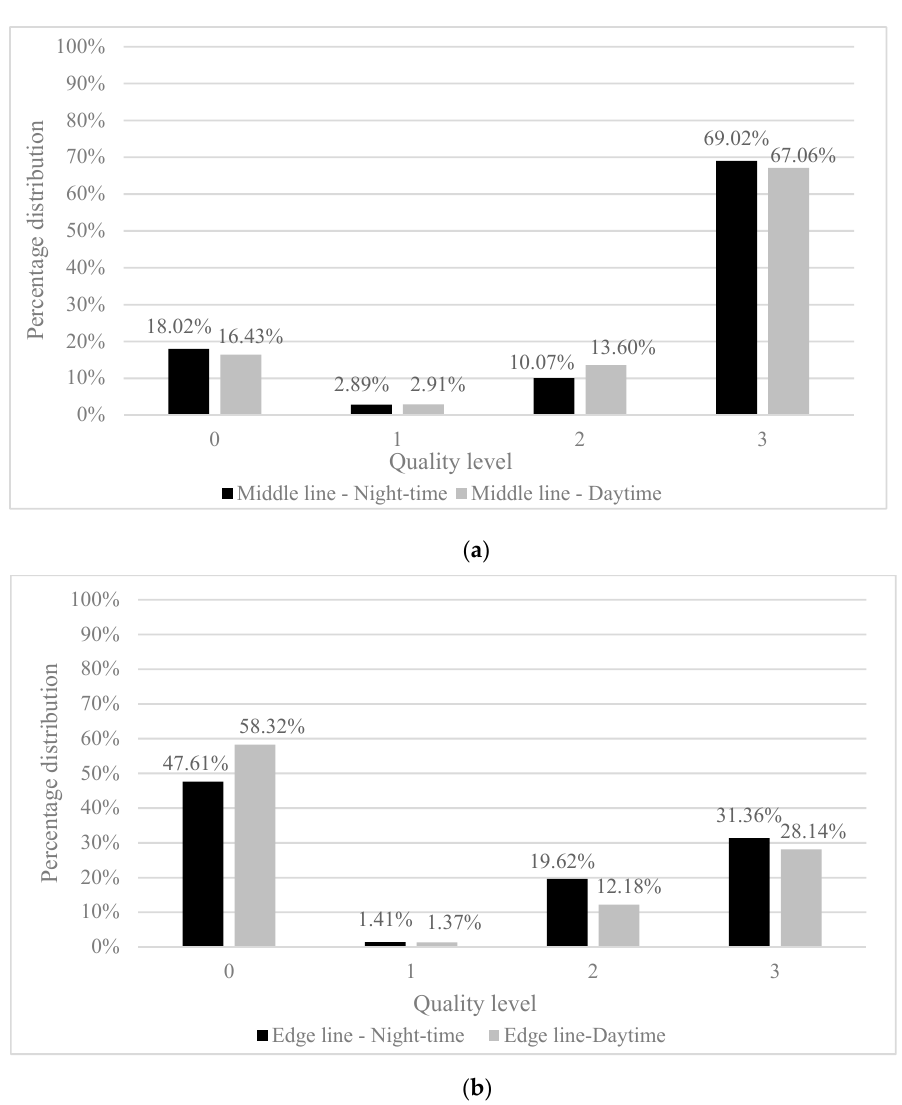
Figure 2. Comparison of the Mobileye readings (quality level) between night-time and daytime quality measurements for middle (Figure a) and edge lines (Figure b).